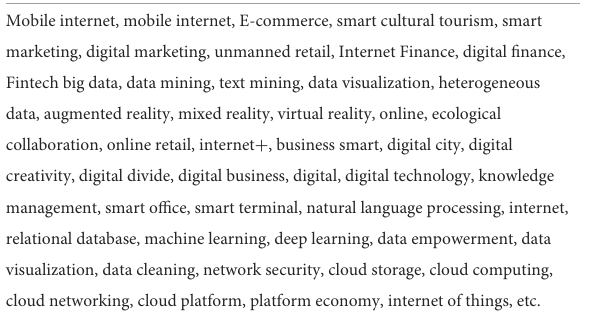
TABLE 6 Keywords related to enterprise digitalization in the cultural